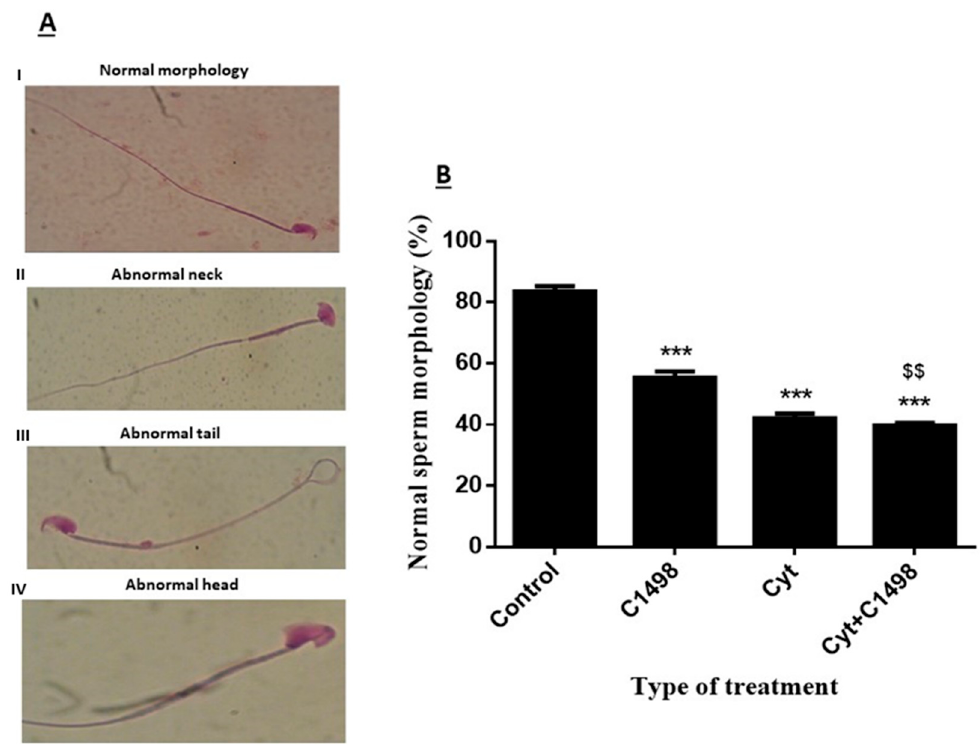
Figure 4. Effect of AML cells, cytarabine, and the combination of both on sperm morphology: Mice were treated as described in Figure 1. Sperm were extracted from the epididymis three weeks post-treatment. Sperm morphology was evaluated following staining with Diff-Quick stain (magnification of × 1000) ( A ). Cells were divided into different types of morphology: (I) normal morphology, (II) abnormal neck, (III) abnormal tail, (IV) abnormal head according to WHO criteria. The percentage of sperm with normal morphology was calculated ( B ). The results are representative of three independent experiment with three mice in each group. * Significant compared to control. $